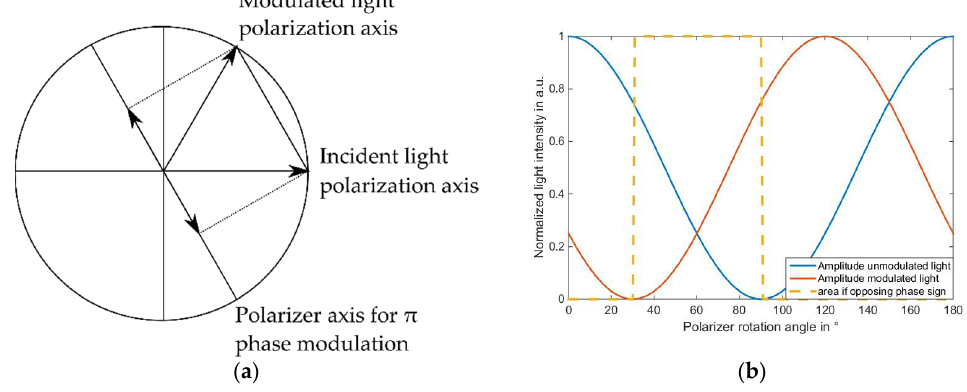
Figure 2. ( a ) Turning polarization modulation into phase modulation. The incident polarization is rotated by the ferroelectric liquid crystal on silicon spatial light modulator (FSLM). An appropriately aligned polarizer then projects both the modulated and the unmodulated light onto the same polarization axis but with opposite sign, resulting in a phase modulation of π . This also ensures that interference between modulated and unmodulated light is possible. ( b ) Simulated intensity of modulated and unmodulated light transmitted through the polarizer in dependence of the polarizer angle with respect to the incident light, following a cos 2 -distribution. The area indicated by the dotted yellow line shows all polarizer rotation angles allowing for opposing polarizations and therefore for an effective phase polarization of π . A maximum interference contrast can be expected for equal intensities, here at 25% of the original.